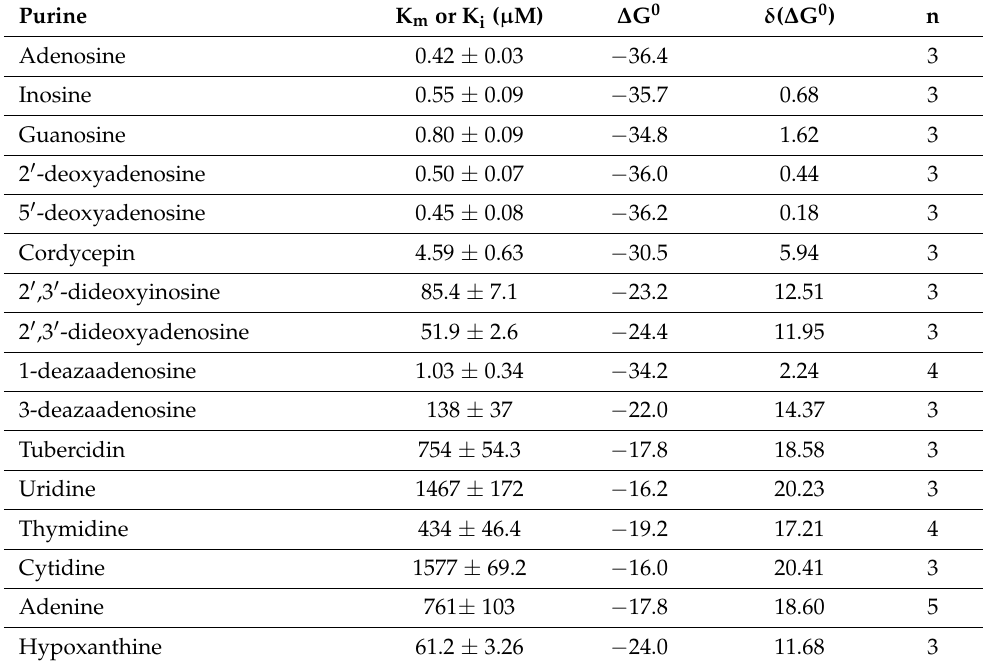
Table 3. K i for purines on the transport of 0.05 µ M [ 3 H]-adenosine by TcoAT1 expressed in SUPKO. Purine K m or K i ( µ M) ∆ G 0